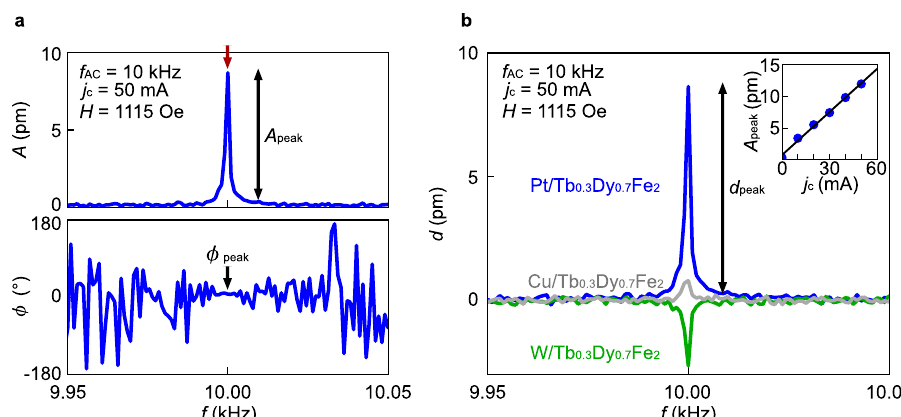
Fig. 2 Observation of spin-current induced mechanical vibration in Tb 0.3 Dy 0.7 Fe 2 . a Frequency f spectra of the mechanical vibration amplitude A (upper panel) and the vibration phase ϕ (lower panel) for the Pt/Tb 0.3 Dy 0.7 Fe 2 sample at the a.c. current frequency f AC = 10 kHz and the a.c. current amplitude j = 50 mA, measured by applying the magnetic fi eld H = 1115 Oe. A c Tb 0.3 Dy 0.7 Fe 2 (a blue solid curve), W/Tb 0.3 Dy 0.7 Fe 2 (a green solid curve), and Cu/Tb 0.3 Dy 0.7 Fe 2 (a gray solid curve) samples. The inset shows the j c dependence of A peak at H = 1530 Oe, where the blue plots and the black solid curve are the measurement data and a linear fi tting